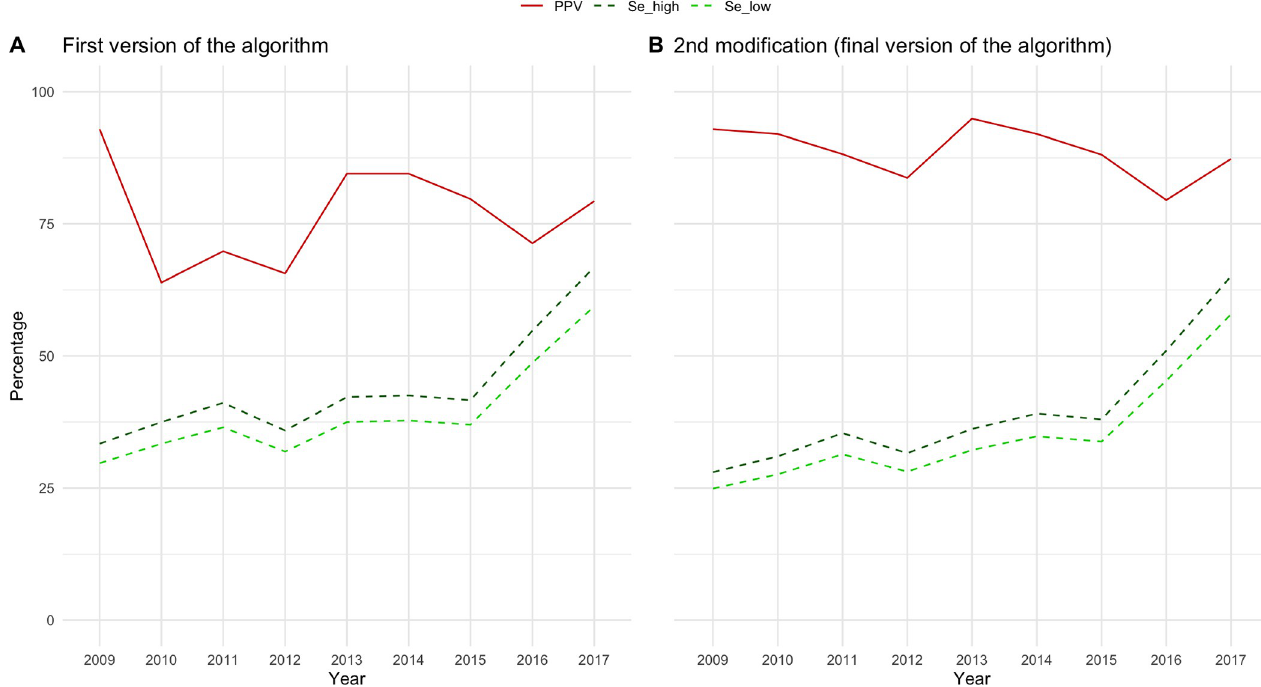
Fig 1. Positive predictive value (PPV) and sensitivity (SE) of first version and final version of the algorithm. The figure shows the validity measures of the first and the final version of the algorithm. PPV was represented in red and SE in green (dark green–higher value of SE; light green–lower value of SE).